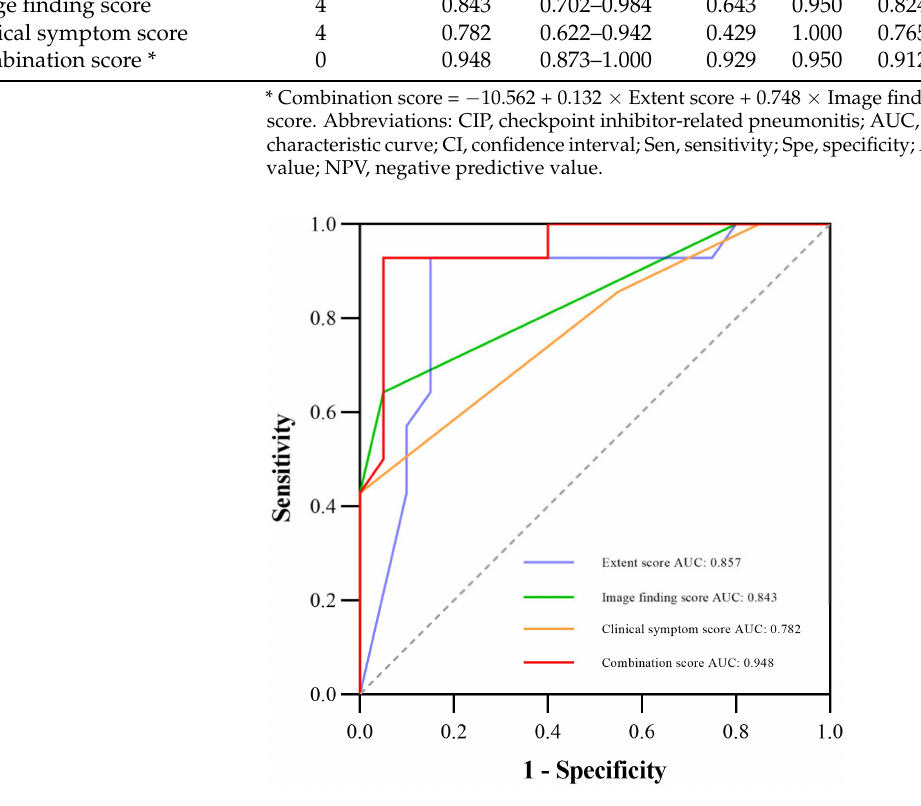
Figure 2. ROC curve for diagnostic performance among the extent, image finding, clinical symp- tom, and the combination scores; the AUCs are 0.857, 0.843, 0.782, and 0.948, respectively. Ab- breviations: AUC, the area under the receiver operating characteristic curve; ROC, the receiver operating